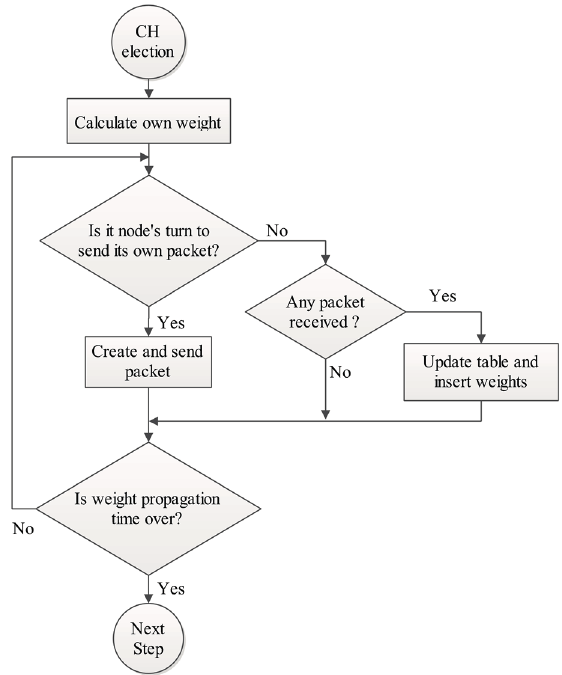
Figure 5. Phase B: Cluster head election phase, Step 1.